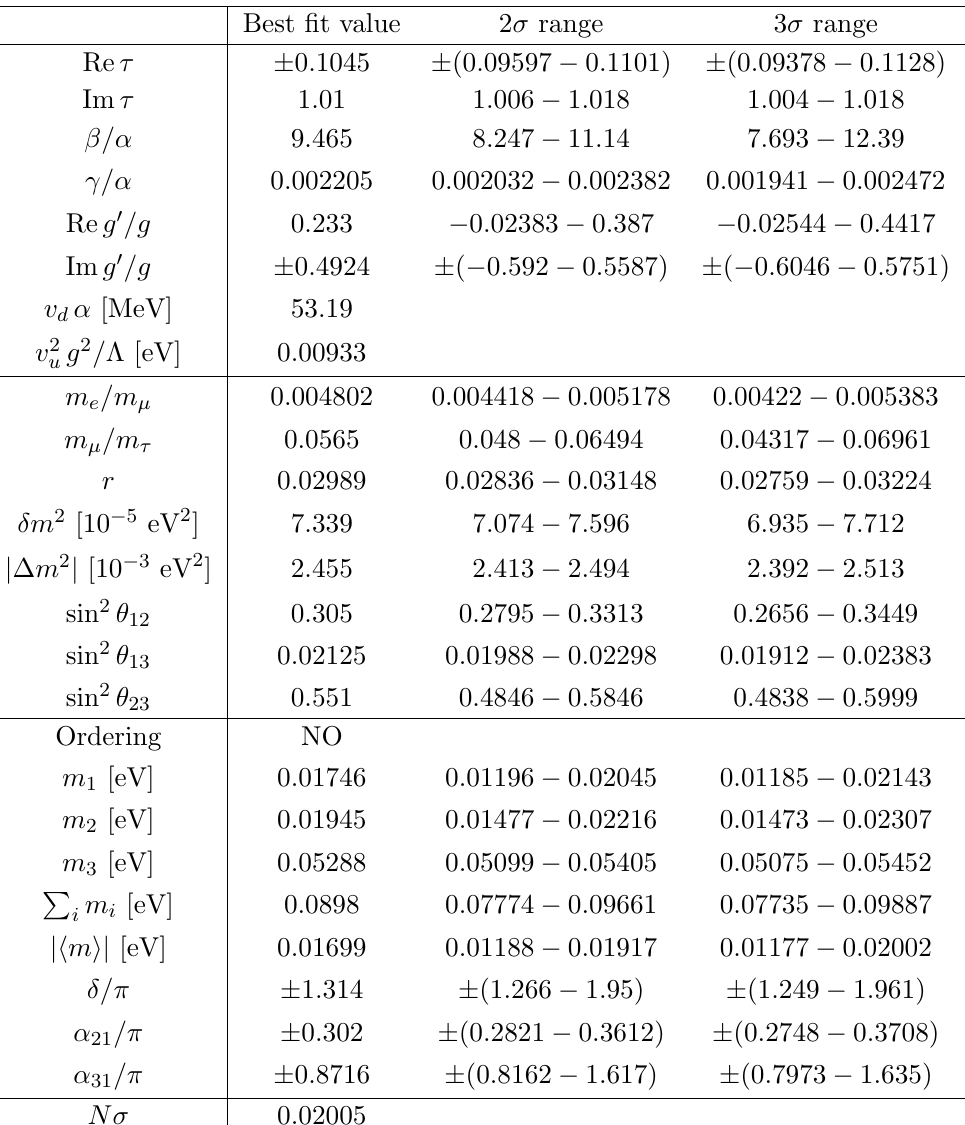
Table 5a. Best (cid:12)t values along with 2 (cid:27) and 3 (cid:27) ranges of the parameters and observables in cases A and A (cid:3) , which refer to ( k (cid:3) ; k g ) = (0 ; 2) and to a certain region in the (cid:28) plane (see (cid:12)gure